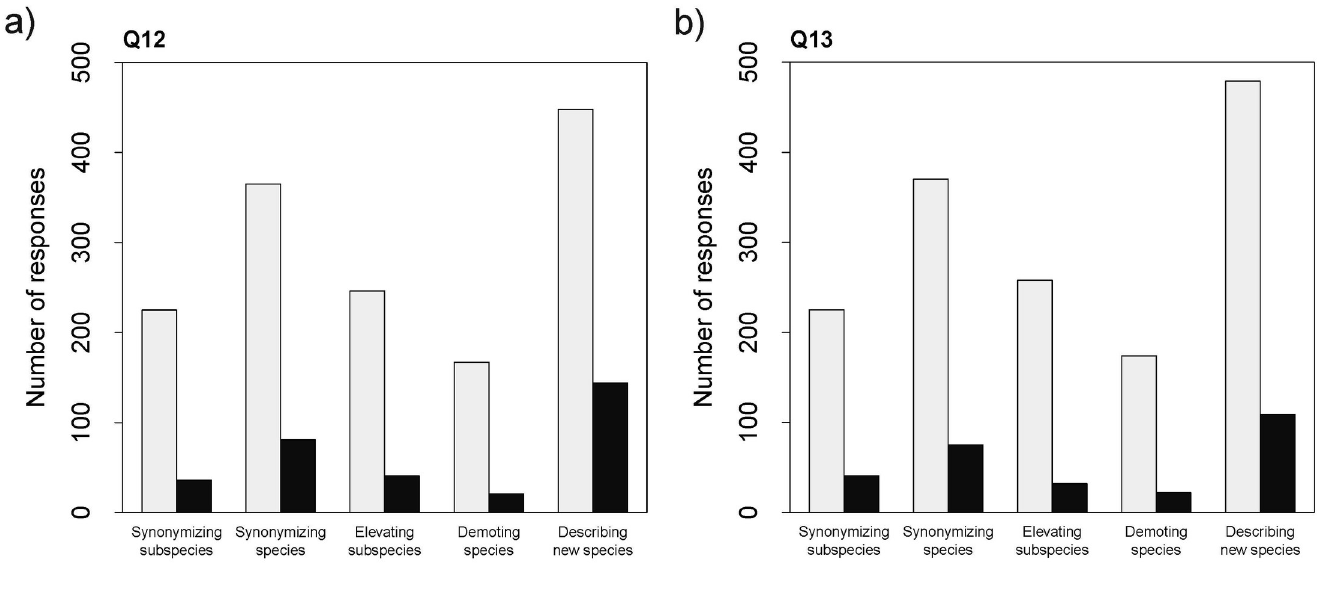
Fig 3. Responses to Q12 and Q13. Number of responses to Q12 and Q13 relative to the different types of study/ nomenclatural acts. Yes = black, no = light grey.